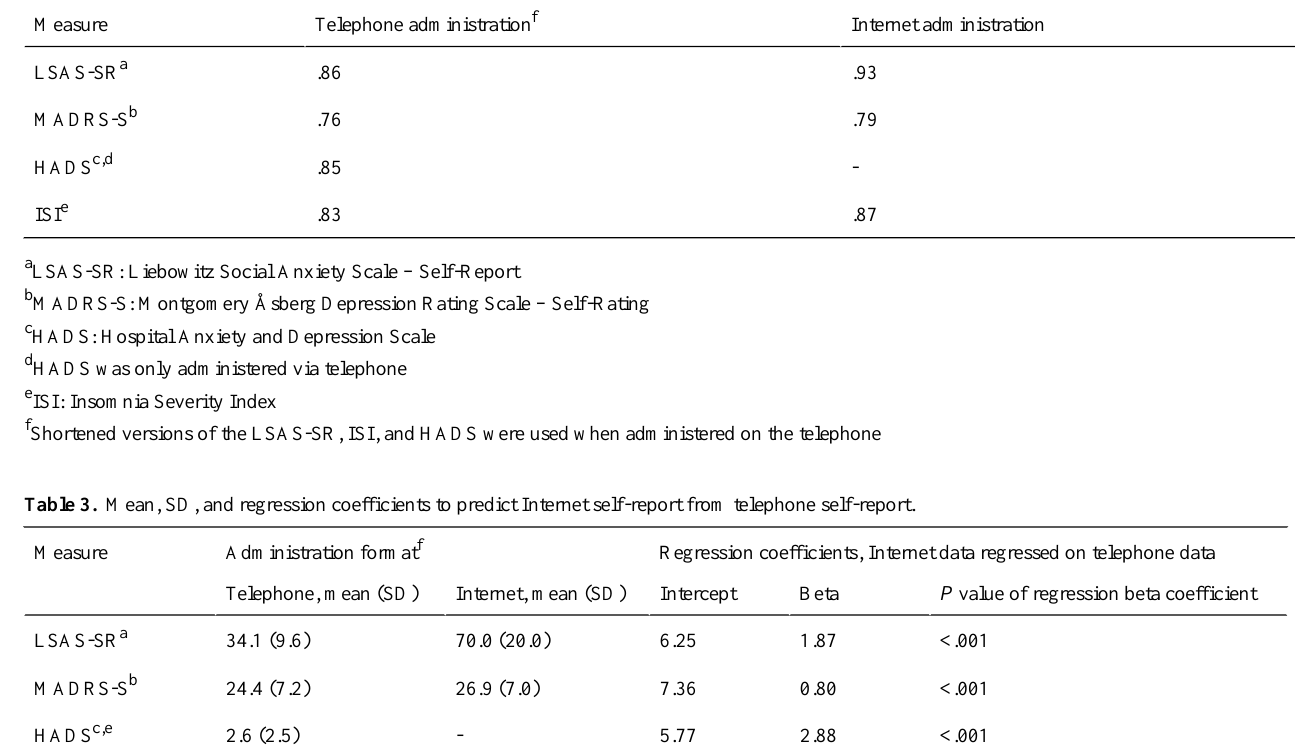
Table 2. Internal consistencies (Cronbach alpha) for the two administration formats for each questionnaire.